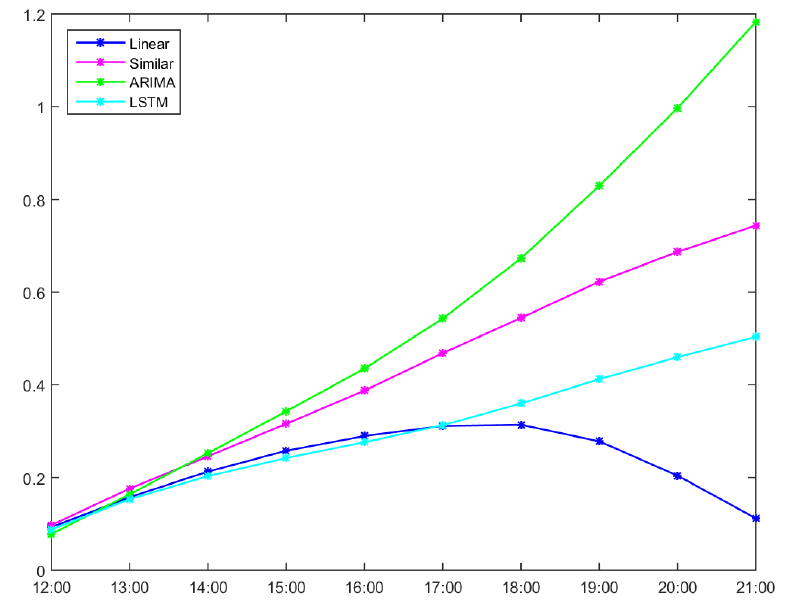
Figure 14. MAE of the four methods for all customers.